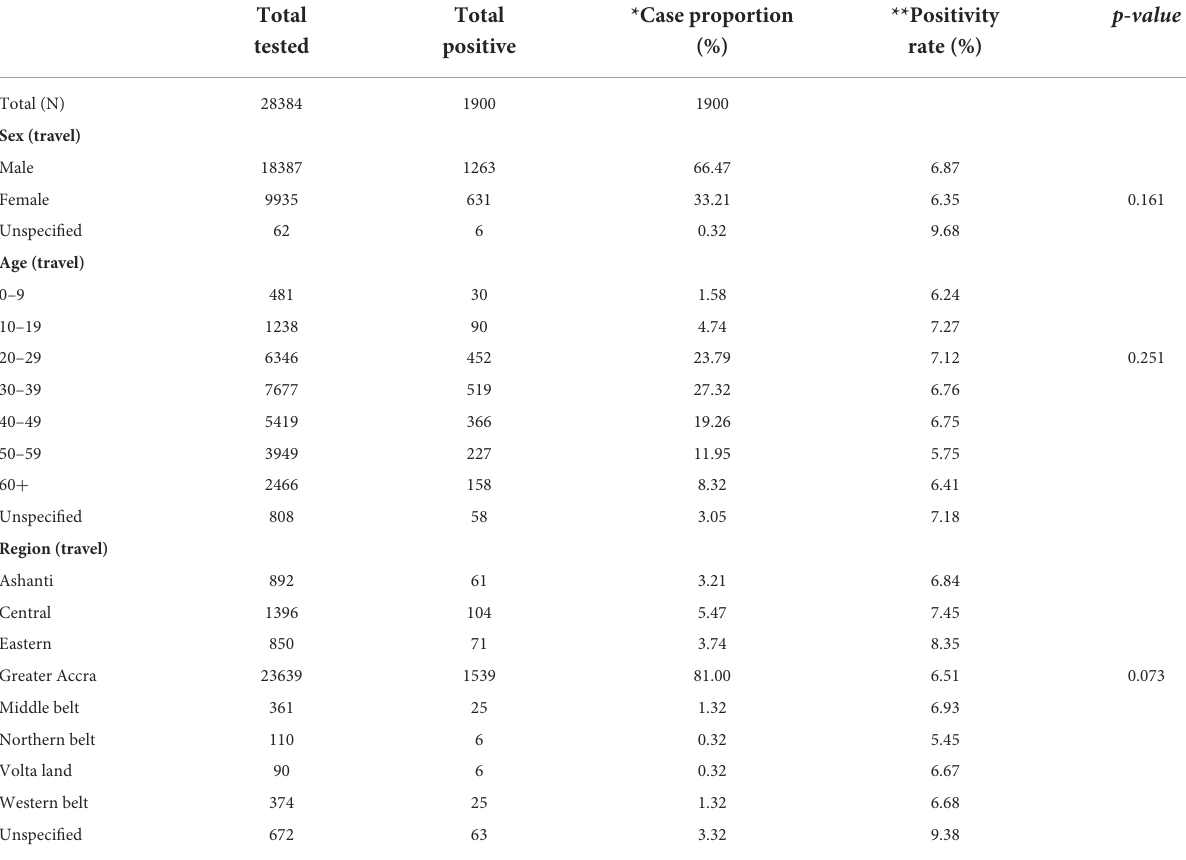
TABLE 2 Demographic and test characteristics of prospective air travelers who took SARS-CoV-2 PCR test at the NWC from July 2020 to July